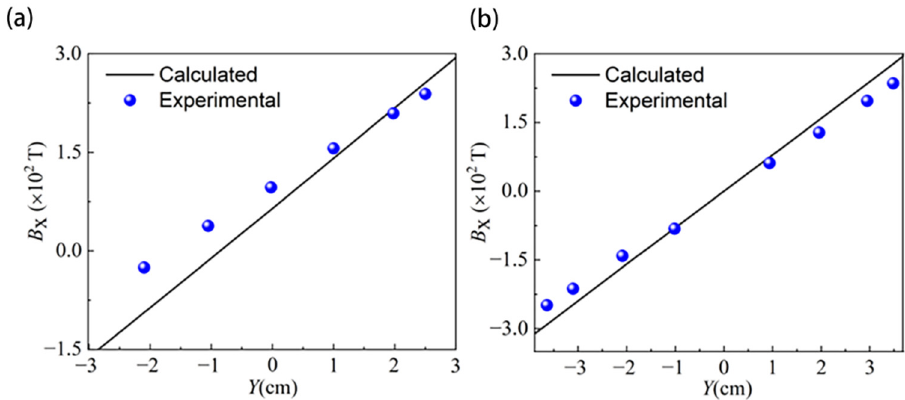
Figure 8. Comparison of magnetic induction intensity in Y direction between calculated and meas- ured values: ( a ) left channel; ( b ) middle channel. sured values: ( a ) left channel; ( b ) middle